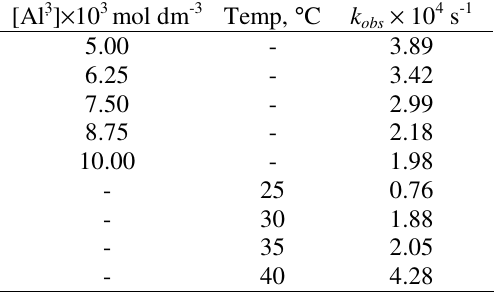
Table 4. Effect of aluminium sulphate and